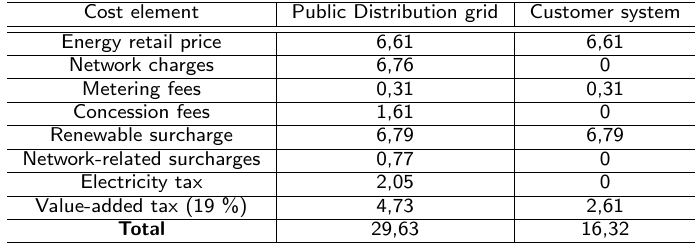
Table 3 Components of the German electricity price in 2018 Cost